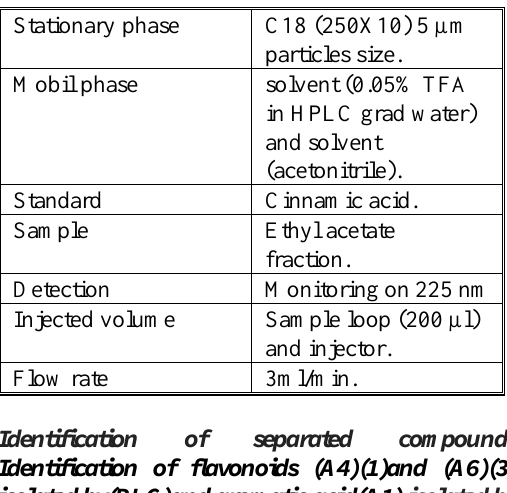
Table 3. Conditions of isolation of HPLC (29)